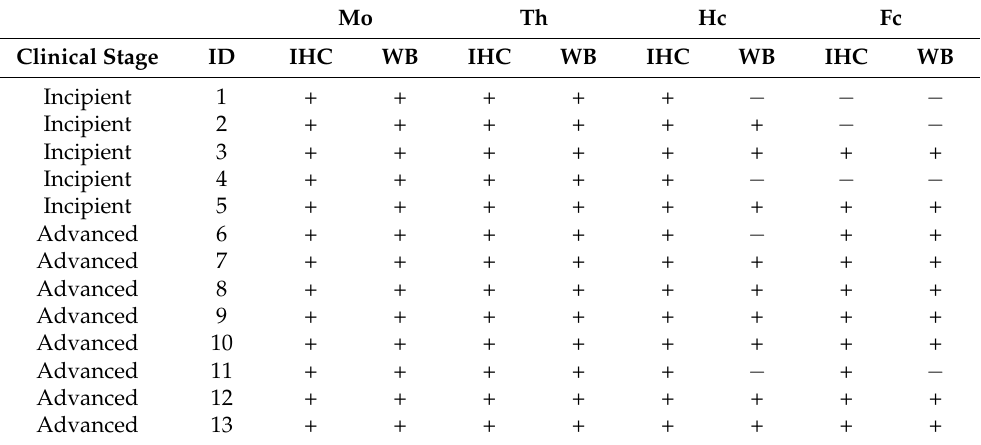
Table 1. PrP Sc detection by immunohistochemistry (IHC) and Western blot (WB) in the medulla oblongata (Mo), thalamus (Th), hippocampus (Hc), and frontal cortex (Fc) of scrapie-infected